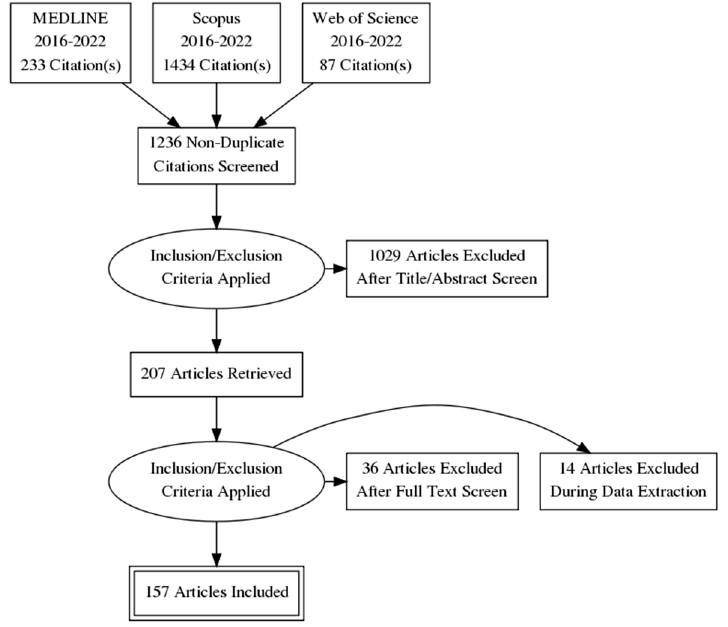
Figure 1. Flow diagram of literature search and selection using the PRISMA (Preferred Reporting Items for Systematic Reviews and Meta-Analyses) principle.